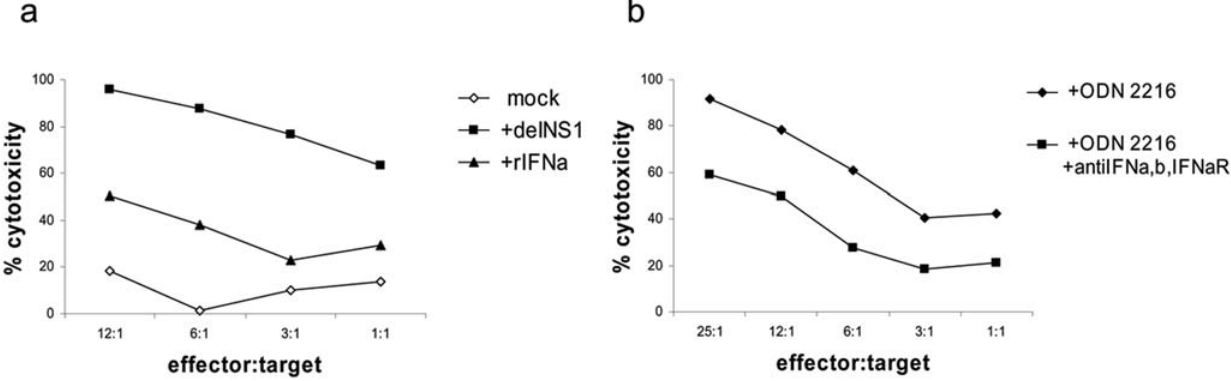
Figure 9. Induction of an anti-tumor cytotoxic immune response by PBMCs infected with delNS1 virus or treated with rIFN a or CpG ODN2216. (a) PBMCs were mock-treated, infected with delNS1 virus (m.o.i.=0.02) or stimulated with 3000 U/ml rIFN a and incubated for 24 hours. Then PBMCs were co-cultured with the target A375 cells for 24 hours and cytotoxicity was assessed. One representative result in percentage of cytotoxicity is shown of three independent experiments, each performed with PBMCs derived from a different donor. (b) PBMCs were incubated with 12.5 m g/ml CpG ODN2216 with or without addition of anti-IFN a , anti-IFN b and anti-IFN a -receptor antibodies, and incubated for 24 hours. Then PBMCs were co-cultured with the target A375 cells for 24 hours and cytotoxicity was assessed. One representative result in percentage of cytotoxicity is shown of two independent experiments, each performed with PBMCs derived from a different donor.